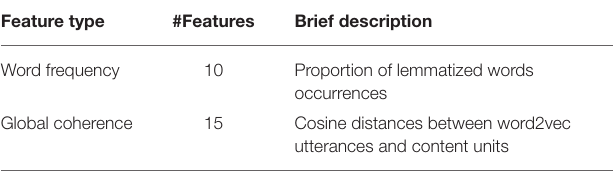
TABLE 6 | Summary of all semantic features